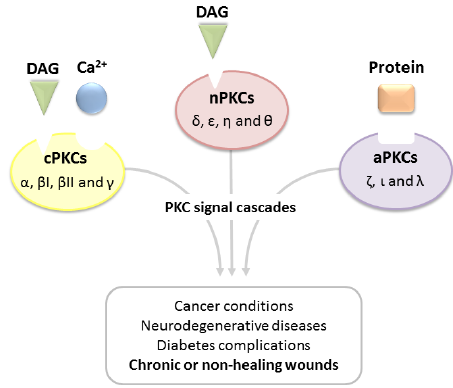
Figure 2. Alterations of PKC signal cascades promote several diseases.